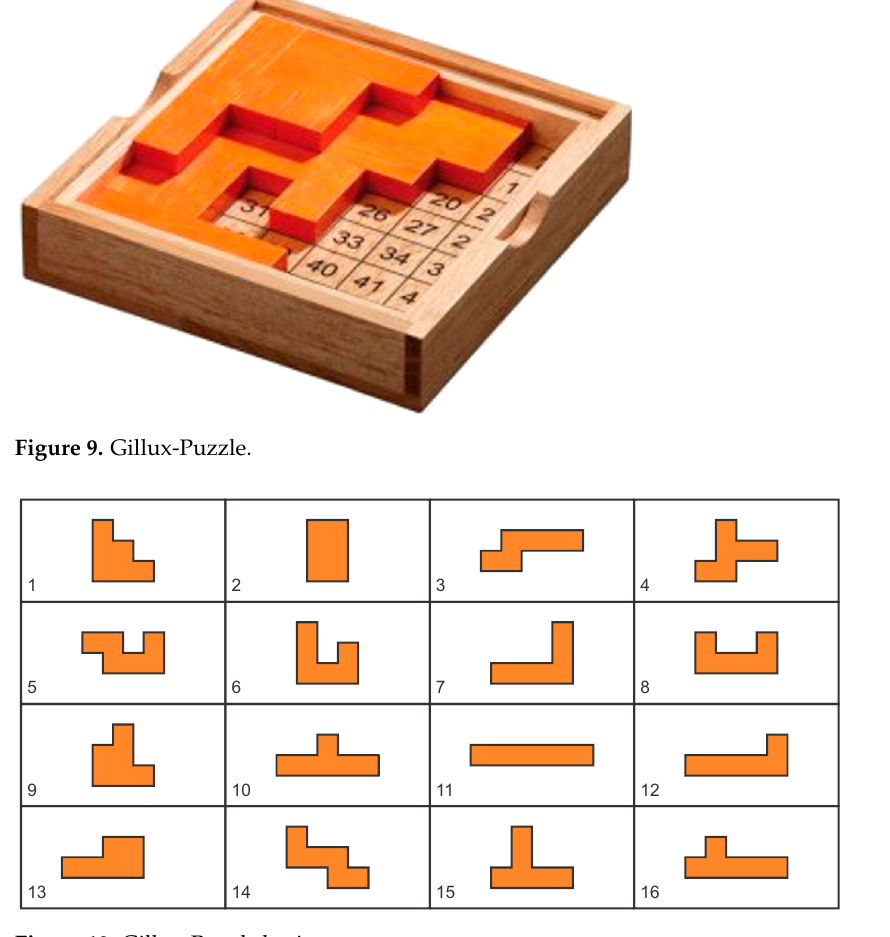
Figure 10. Gillux-Puzzle basic parts.